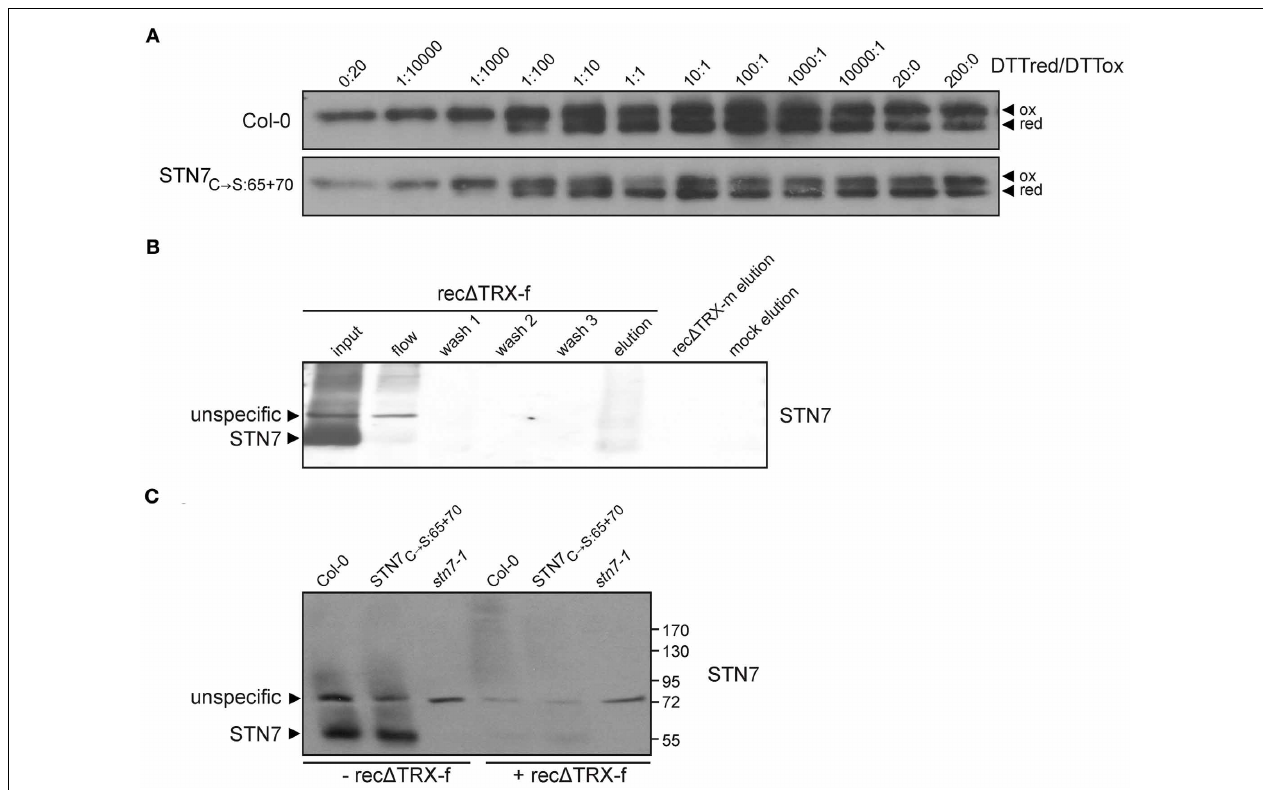
FIGURE 4 | Redox sensitivity of STN7. (A) Redox titration of STN7 variants. Thylakoids of WT (Col-0) and STN7 C −→ S : 65 + 70 were equilibrated at various redox potentials using the DTTred/DTTox redox couple. After separation by non-reducing SDS-PAGE, STN7 was detected by immunoblotting. DTTred/DTTox ratios are indicated above each lane. Oxidized (ox) and reduced (red) forms of the STN7 monomer are indicated by black arrowheads. (B) STN7—TRX-f interaction assayed by thioredoxin affinity chromatography. His-tagged recombinant thioredoxins f and m, with one cysteine replaced by serine (rec (cid:2) TRX-f, -m), were bound to Ni-NTA and incubated with thylakoids solubilized with 1.5% digitonin corresponding to 2mg of Chl. After several washes, the